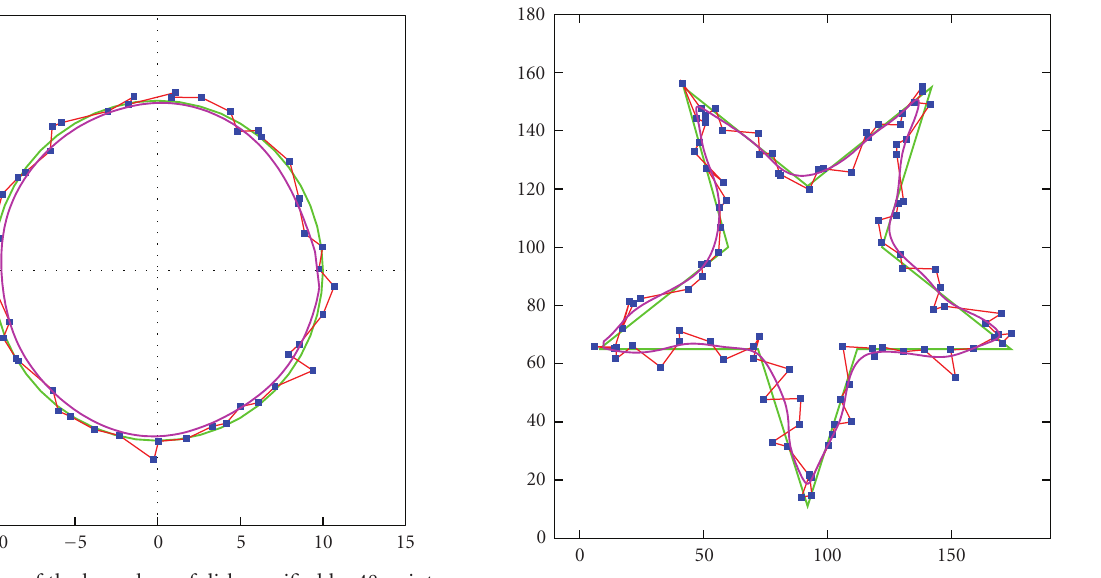
Figure 4: Recovery of the boundary of the star specified by 100 points: 10 along each arm with Gaussian noise of ν = 4. The boundary is constructed using approximate interpolation, using σ − 6 and σ − 4 . The recovered curve is shown A = 1 × 10 B = 1 × 10 as a thicker line.